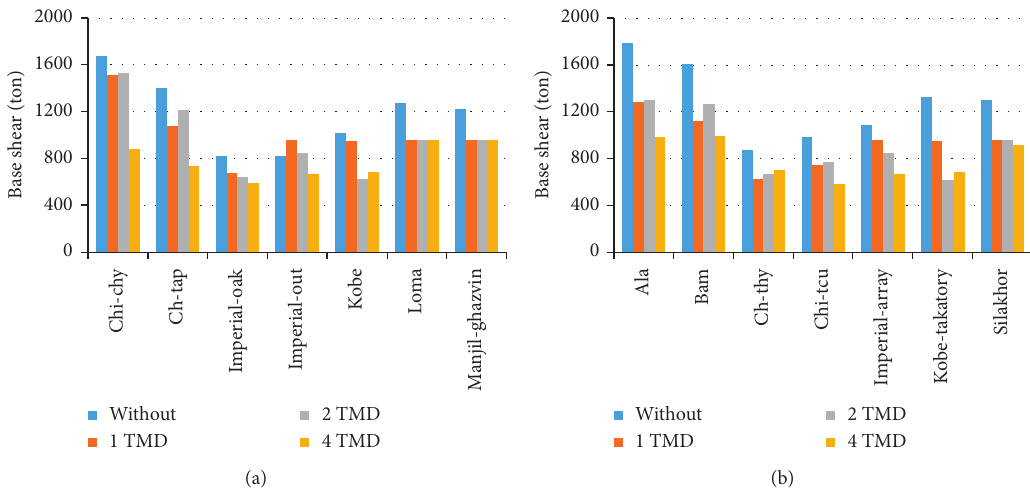
Figure 13: Base shear with damper in the ninth story under the near-field (right) and far-field (left) earthquakes in the regular 10-story model.